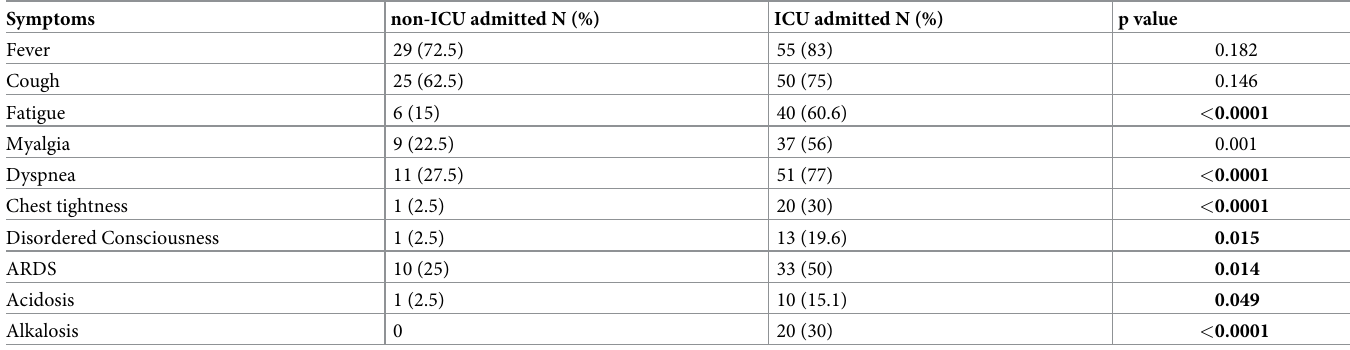
Table 3. Symptoms upon admission among the COVID-19 positive patients demarcated into non-ICU and ICU admitted.